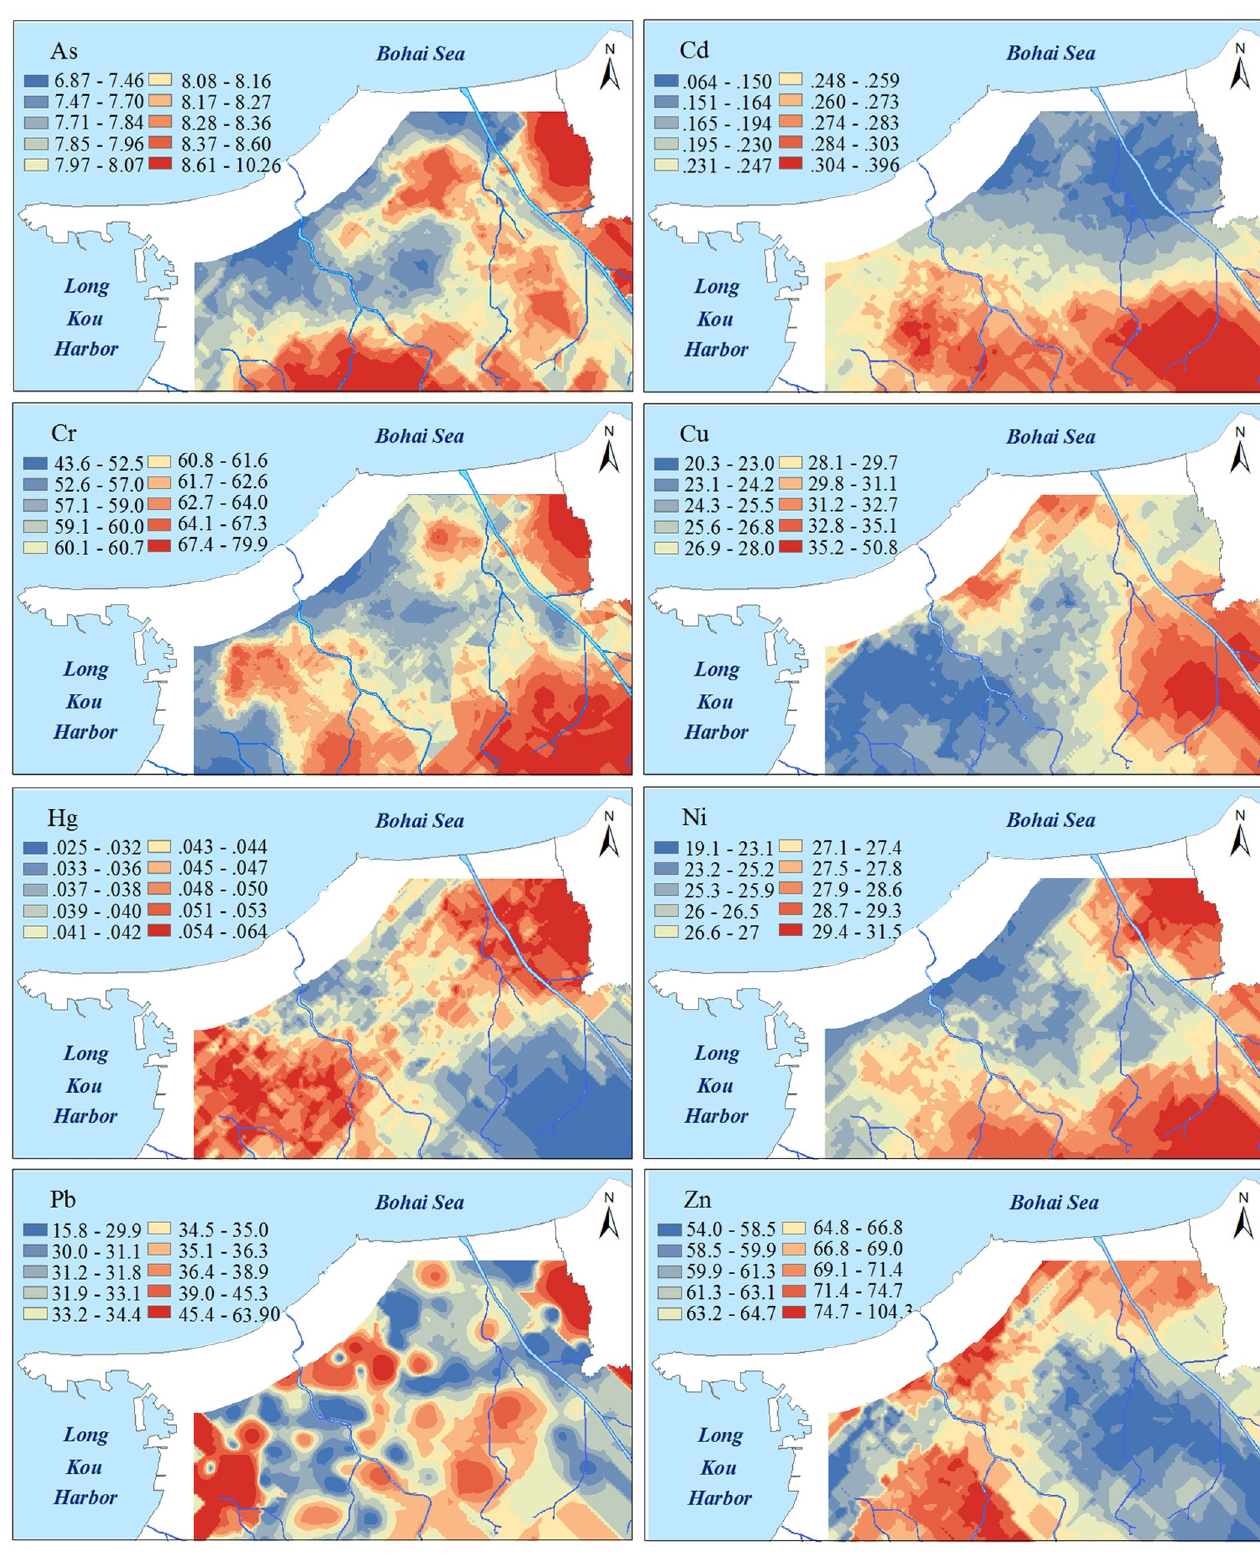
Fig 6. Kriged interpolation of the concentration of potentially toxic elements. (The interpolated map plotted with the optimal ordinary kriged interpolation model). https://doi.org/10.1371/journal.pone.0238513.g006 PLOS ONE | https://doi.org/10.1371/journal.pone.0238513 September 3,